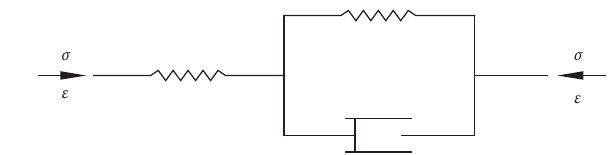
Figure 3: The generalized Kelvin model with the humidity